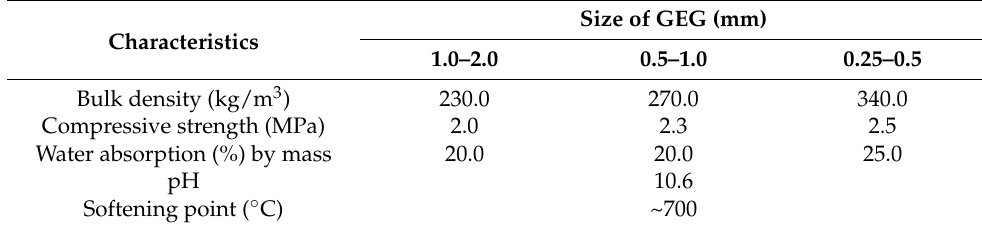
Table 3. The characteristics of GEG.